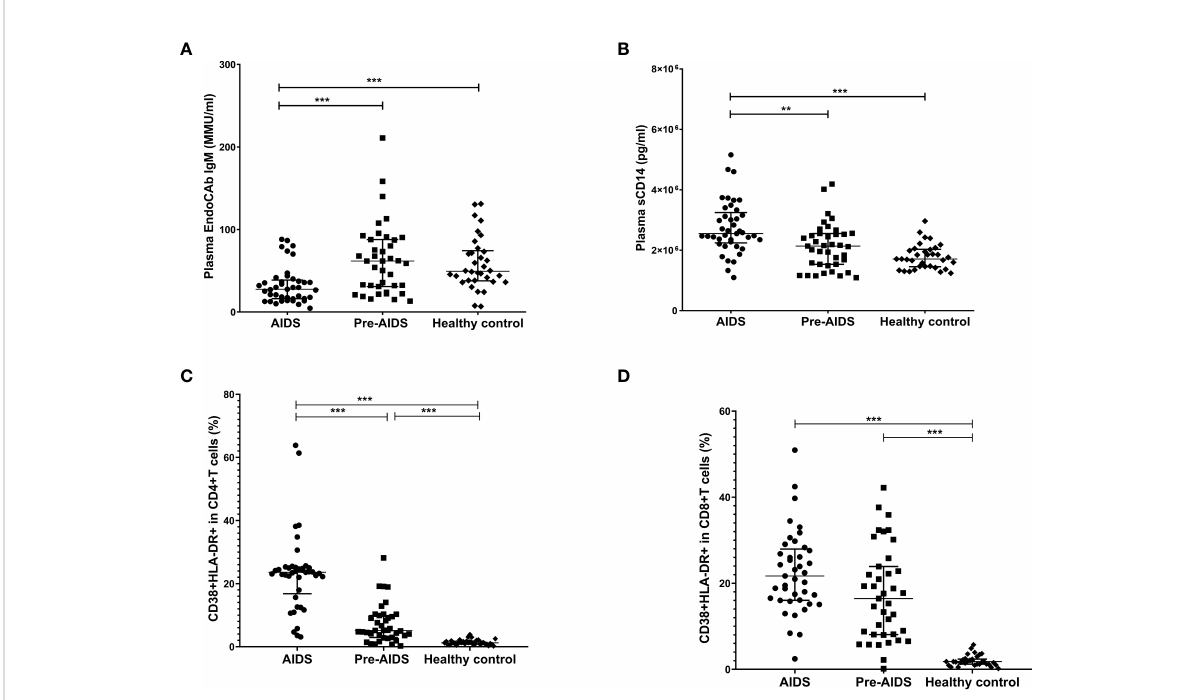
FIGURE 1 Markers of microbial translocation and immune activation in the AIDS group, pre-AIDS group and the healthy control group. Compared with the pre-AIDS and healthy control groups, EndoCAb IgM levels were signi fi cantly lower (A) , and plasma sCD14 levels were signi fi cantly higher (B) . The AIDS and pre-AIDS groups had a signi fi cantly higher proportion of activated CD4+ T cells (C) and CD8+ T cells (D) than the healthy control group. **: 0.001 ≤ P < 0.010; ***: P <